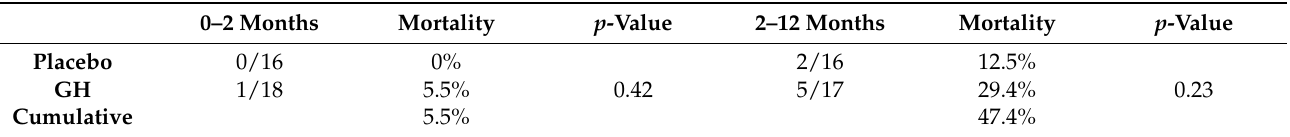
Table 6. Mortality in the GHAS trial . Short-term mortality: 0–2 months (period of treatment). Long-term mortality: 2–12 months (observation period).